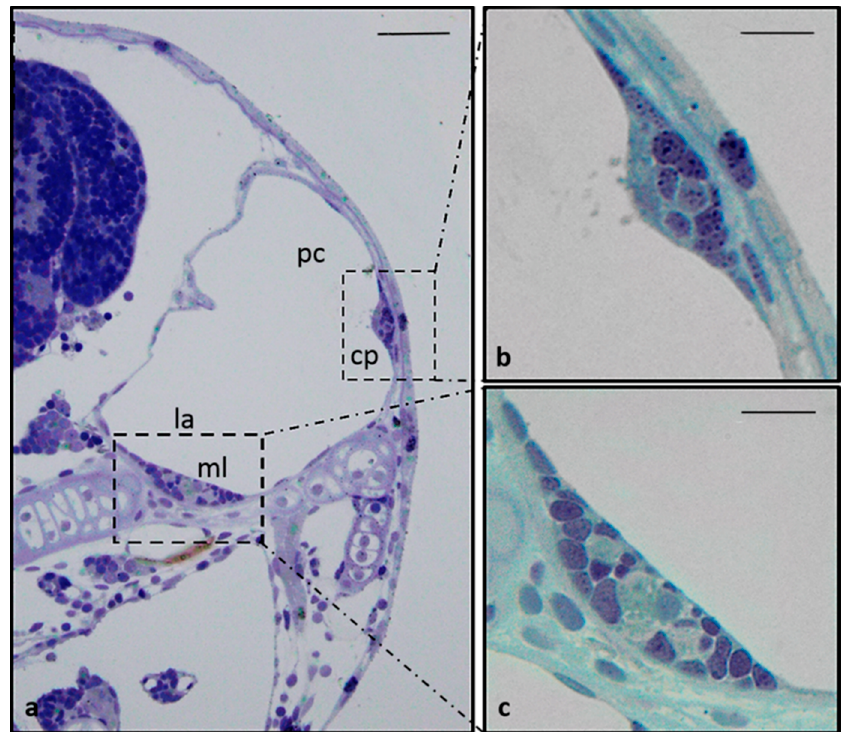
of sensory epithelial cells of lateral cristae: ( c ) High magnification saccular macula. ml—macula lagena; macula. ml—macula lagena; la—lagena; pc—posterior canal, cp—crista posterior. Scale bars: ( a ) la—lagena; pc—posterior canal, cp—crista posterior. Scale bars: ( a ) 30 µ m, ( b , c ) 9 µ